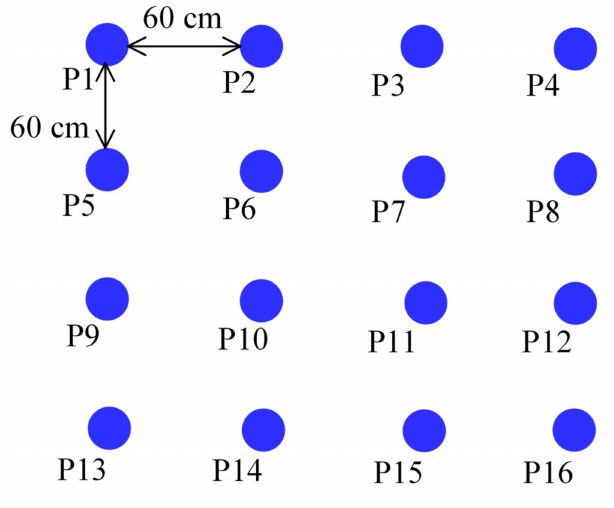
Figure 11. Sampling points arrangement. Table 1. The differentiation calculation of the magnetic field strength of the grid sampling points in a small